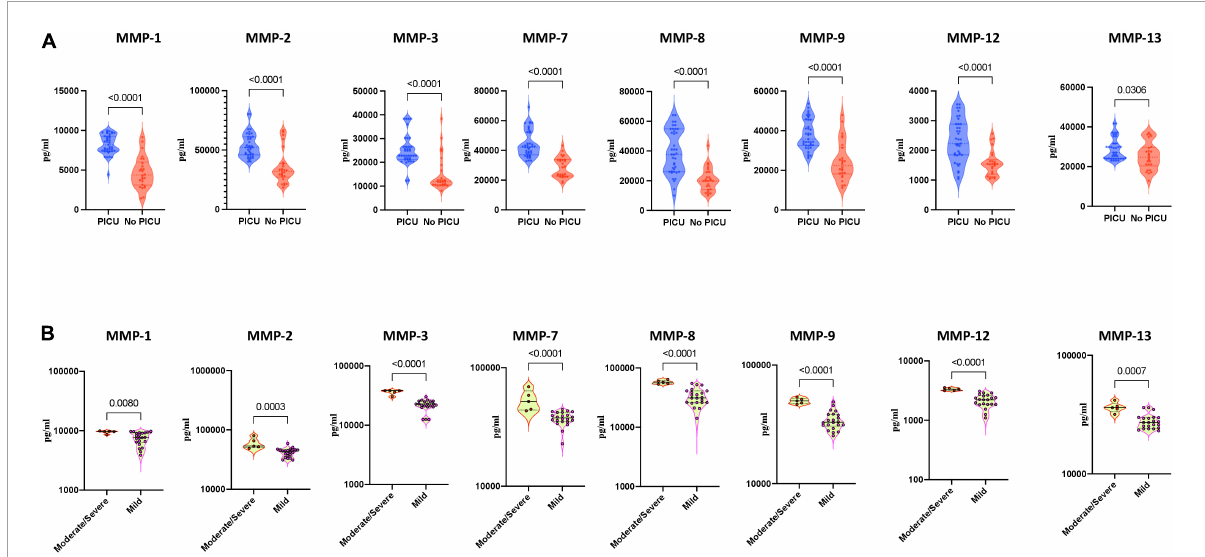
FIGURE3 Heightened plasma matrix metalloproteinases (MMP) levels are associated with disease severity in multisystem inflammatory syndrome in children (MIS-C) and COVID-19. (A) The plasma levels of MMPs-1, 2, 3, 7, 8, 9, 12 and 13 were measured in MIS-C children with PICU care ( n = 39) and MIS-C children no PICU care ( n = 26). (B) The plasma levels of MMPs-1, 2, 3, 7, 8, 9, 12 and 13 were measured in COVID-19 children with moderate to severe ( n = 5) and children with mild ( n = 22) disease. The data are represented as scatter violin plots with each circle representing a single individual. P values were calculated using the Mann–Whitney test with Holm’s correction for multiple